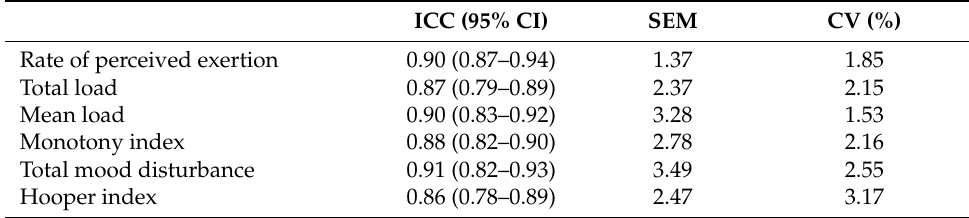
Table 1. Test–retest reliability of the variables.